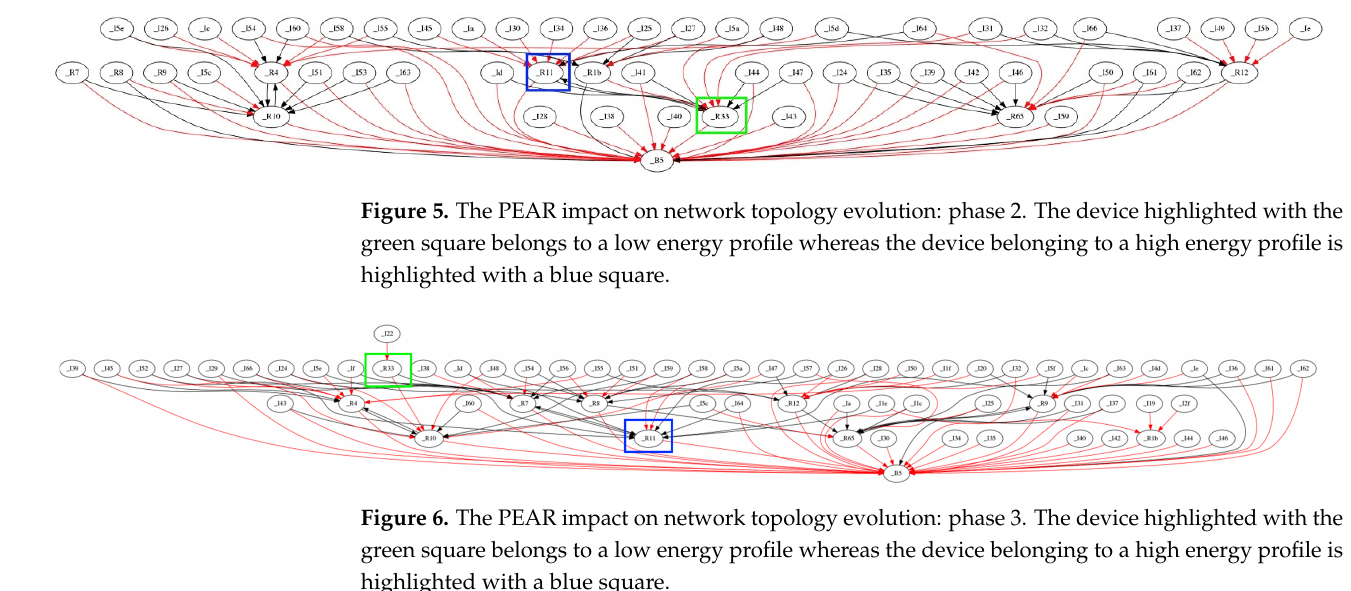
Figure 7. The ISA100.11a certified hardware devices employed in the experimental setup at CDS premises (Cluj-Napoca, Romania)—two out of three test batches.